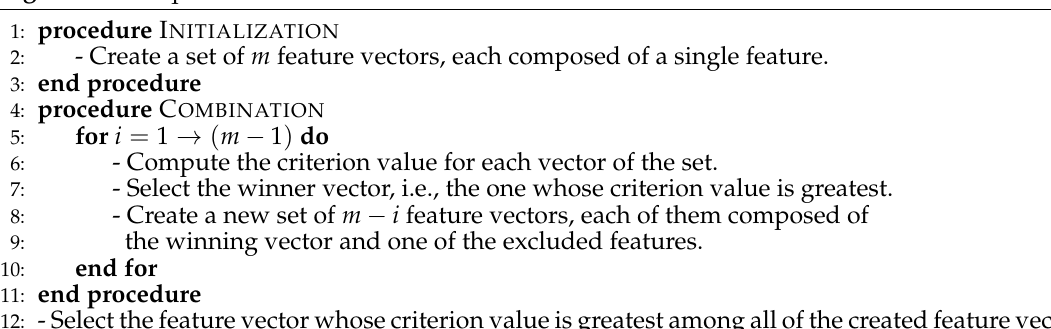
Algorithm 1 Sequential forward